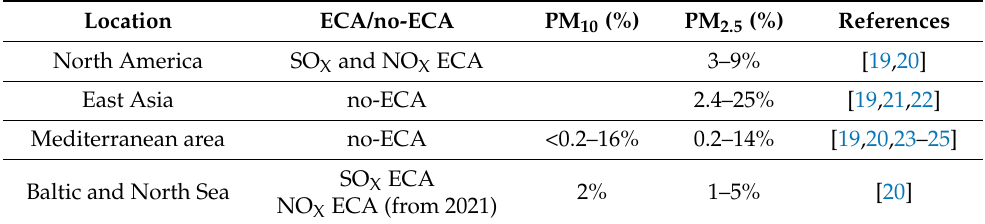
Table 1. Shipping primary contributions (range, expressed as %) to PM concentration estimated using source-apportionment approaches worldwide in ECA and outside